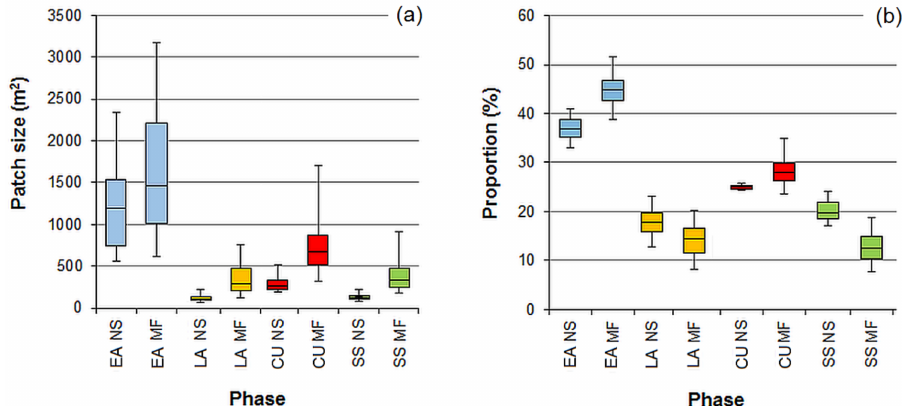
Figure 7. Mean size ( a ) and frequency ( b ) of the patches assigned to the early accumulation (EA), late accumulation (LA), culmination (CU), and steady-state (SS) phases for the original (NS = without smoothing) and smoothed (MF = majority filter) classification outputs. The bars, boxes, and whiskers illustrate the median, interquartile range, and 5th and 95th percentile values obtained from 100 simulations of a random tree distribution in the model stand (see Figure 2). In the classification procedure, the moving window diameter was 15 m, and for the noise smoothing, a majority filter with the kernel 5 × 5 cells was